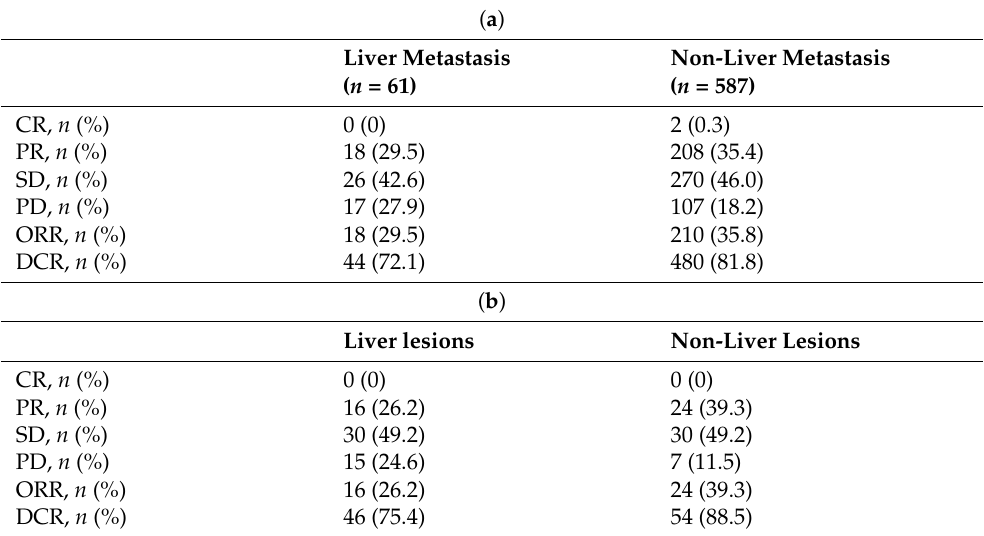
Table 2. Immunotherapy efficacy of NSCLC patients. ( a ) Liver metastases group and non-liver metastasis group. ( b ) Liver and non-liver lesions in NSCLC patients with liver metastasis.